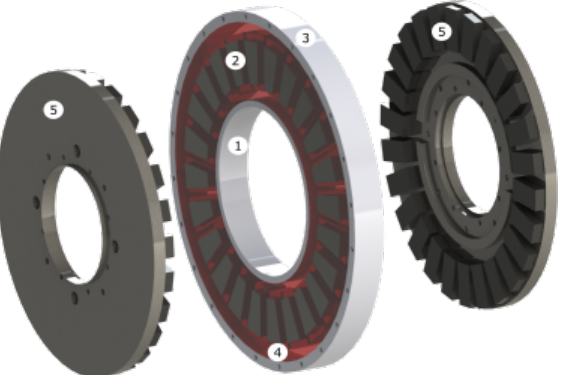
Figure 4. Yokeless and Segmented Armature Axial Flux Permanent Magnet Synchronous Machine: (1) Thermal end-winding interconnection ring (2) Concentrated winding tooth coil (3) Aluminium housing (4) Epoxy impregnation (5) Permanent magnet